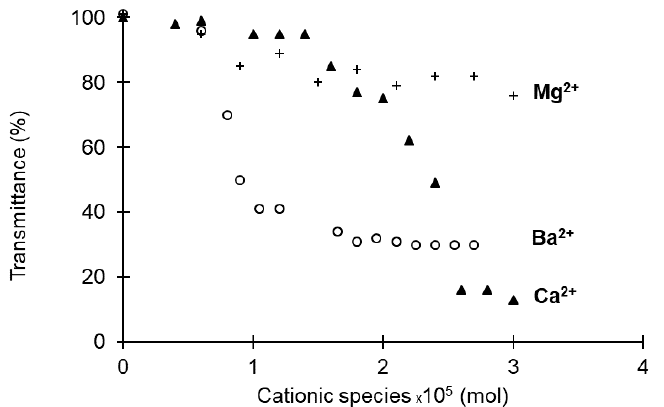
Figure 5. Effect of the cationic species on the network formation with a PHOSO 3 − (concentration of 27 g · L − 1 ).